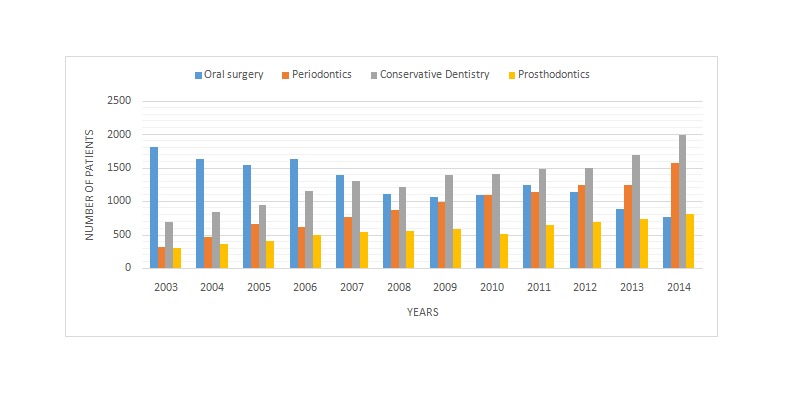
Graph 2: Distribution of referral of patients during 2003-2014 time period.